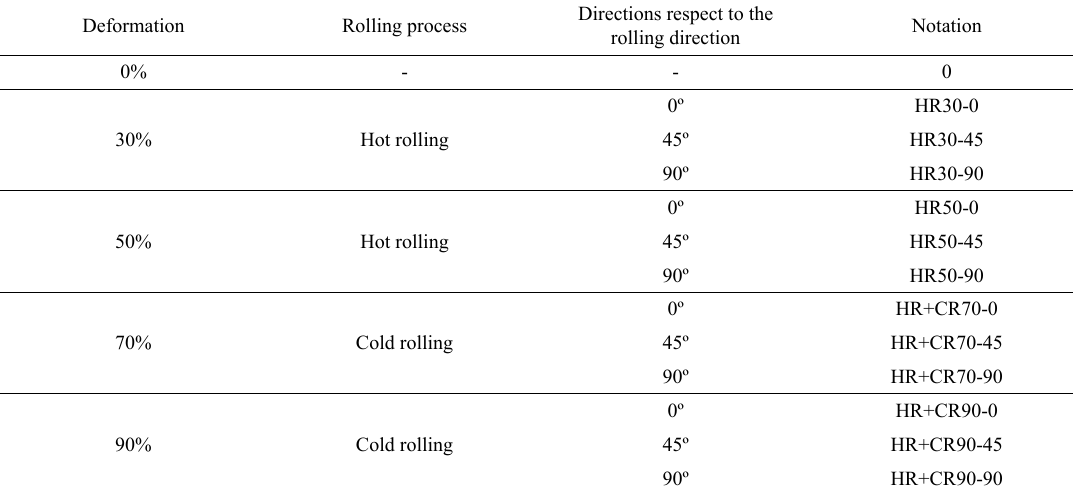
Table 3. Deformation information and number of the samples.